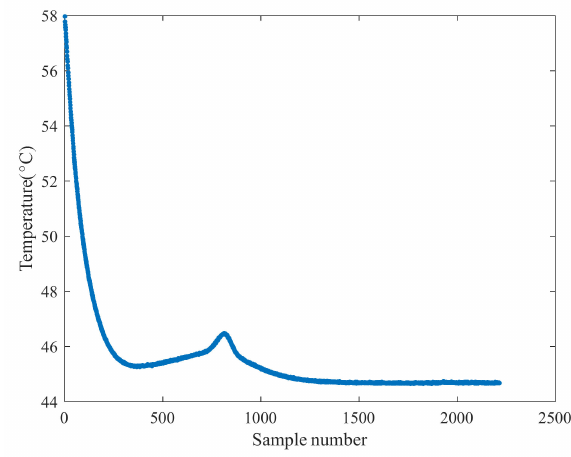
Figure 2. Battery temperature change curve.